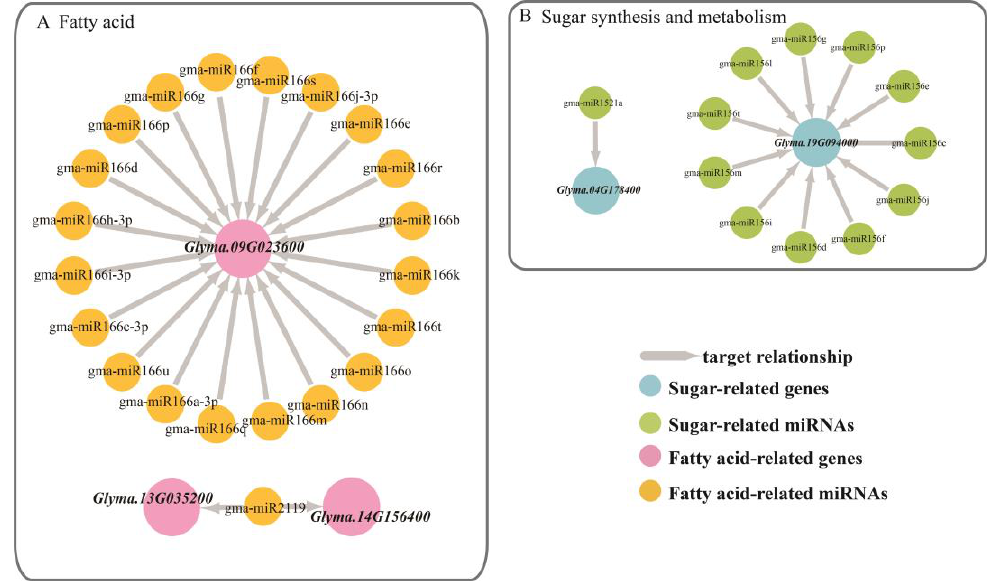
Figure 5. Regulatory network relationships between differentially expressed miRNAs and their targeted genes related to storage materials. The arrow represented targeted regulation. ( A ) The miRNA regulatory network targets genes associated with fatty acids. Yellow circle represented fatty acid-related miRNAs and pink circle represented fatty acid-related genes. ( B ) The miRNA regulatory network targets genes associated with sugar synthesis and metabolism. Green circle represented sugar-related miRNAs and blue circle represented sugar-related genes.